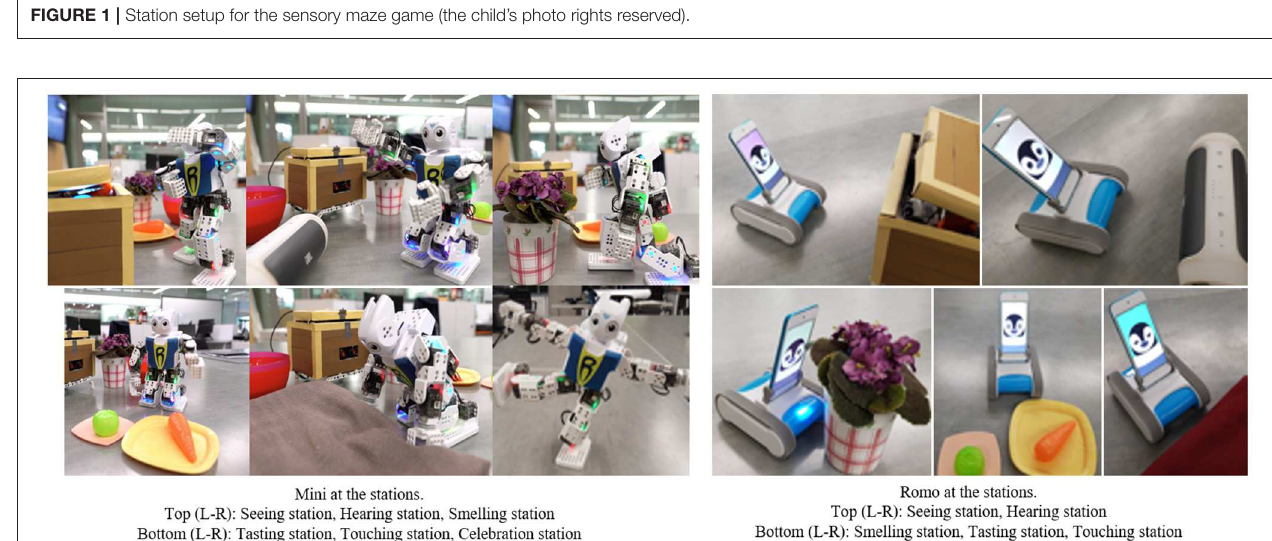
FIGURE 2 | The two robots at each sensory station, adapted from Javed et al. (2019).